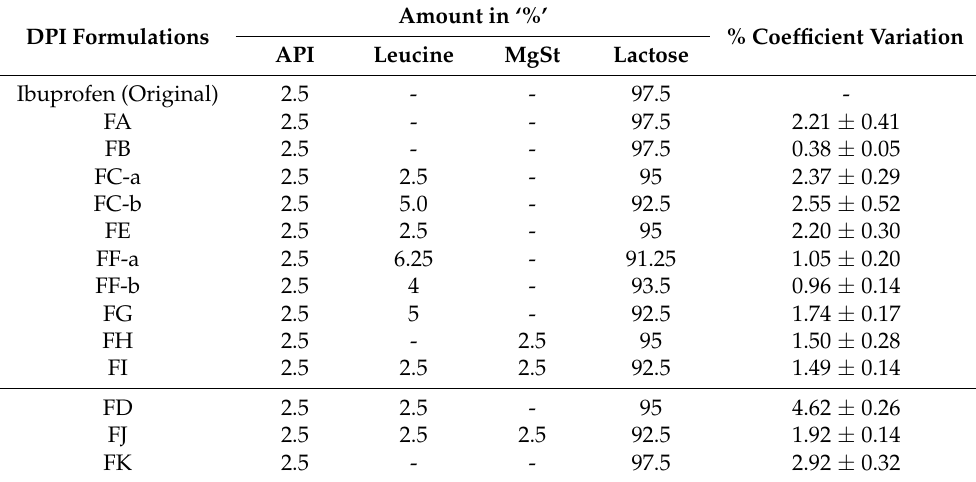
Table 1. Compositions of developed DPI formulations with carrier lactose and homogeneity of mixtures (n = 3, Mean ±